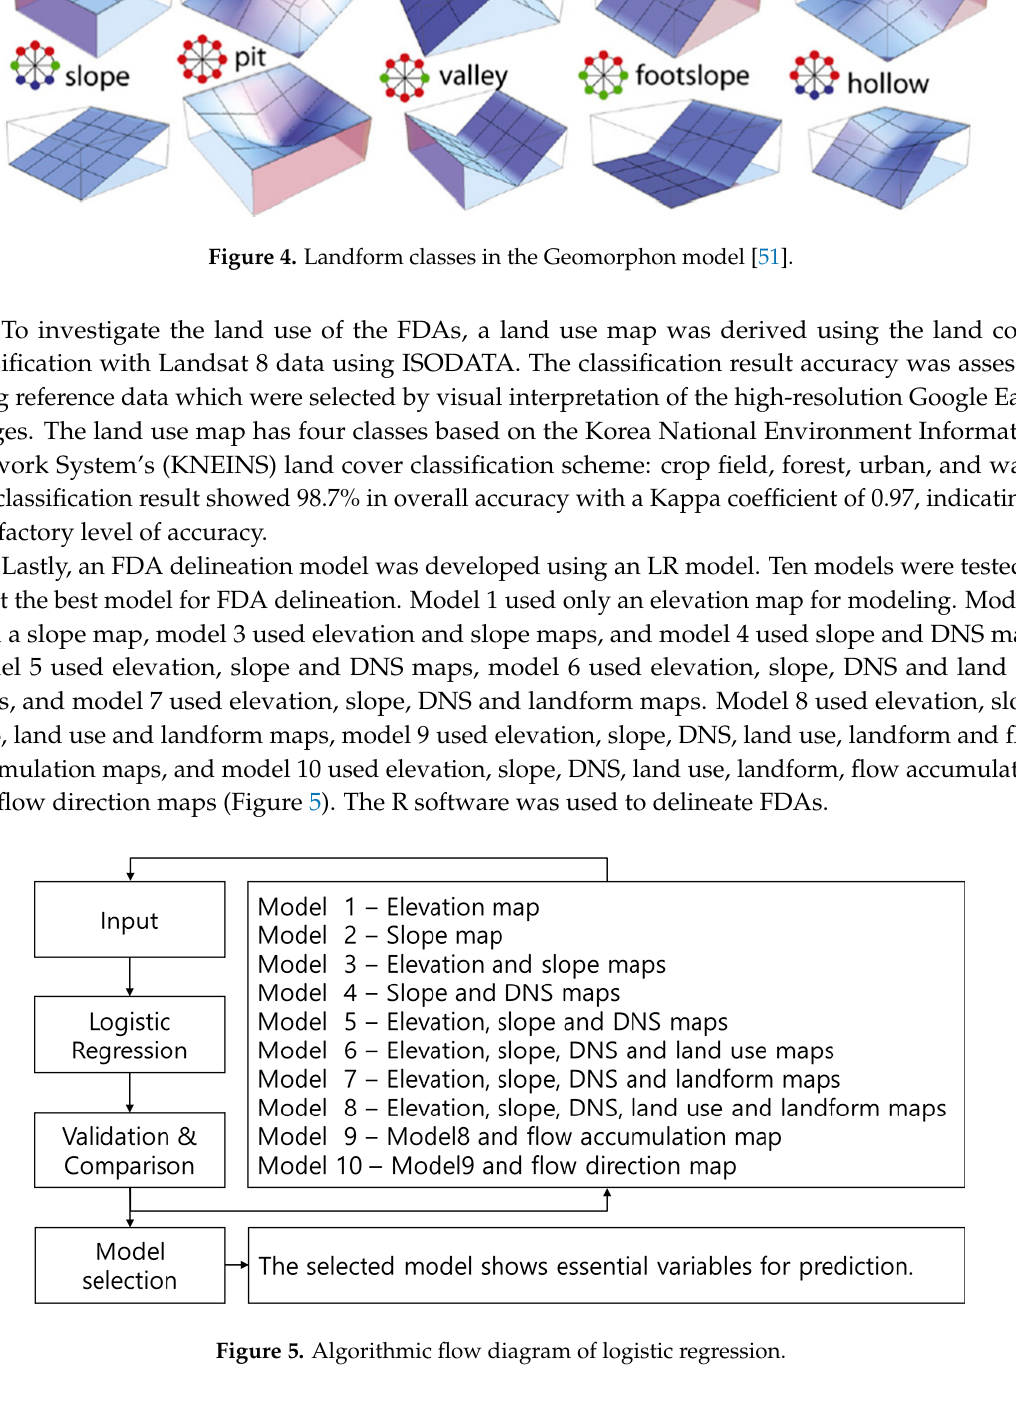
Figure 4. Landform classes in the Geomorphon model [51].